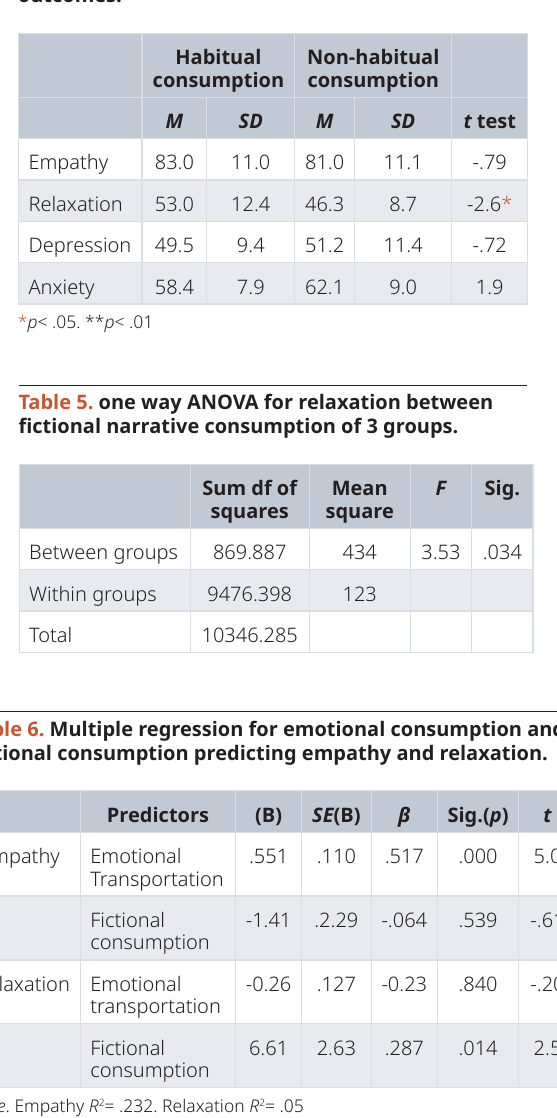
Table 4. T-test results comparing habitual and non- habitual consumption of fictional narratives on outcomes.